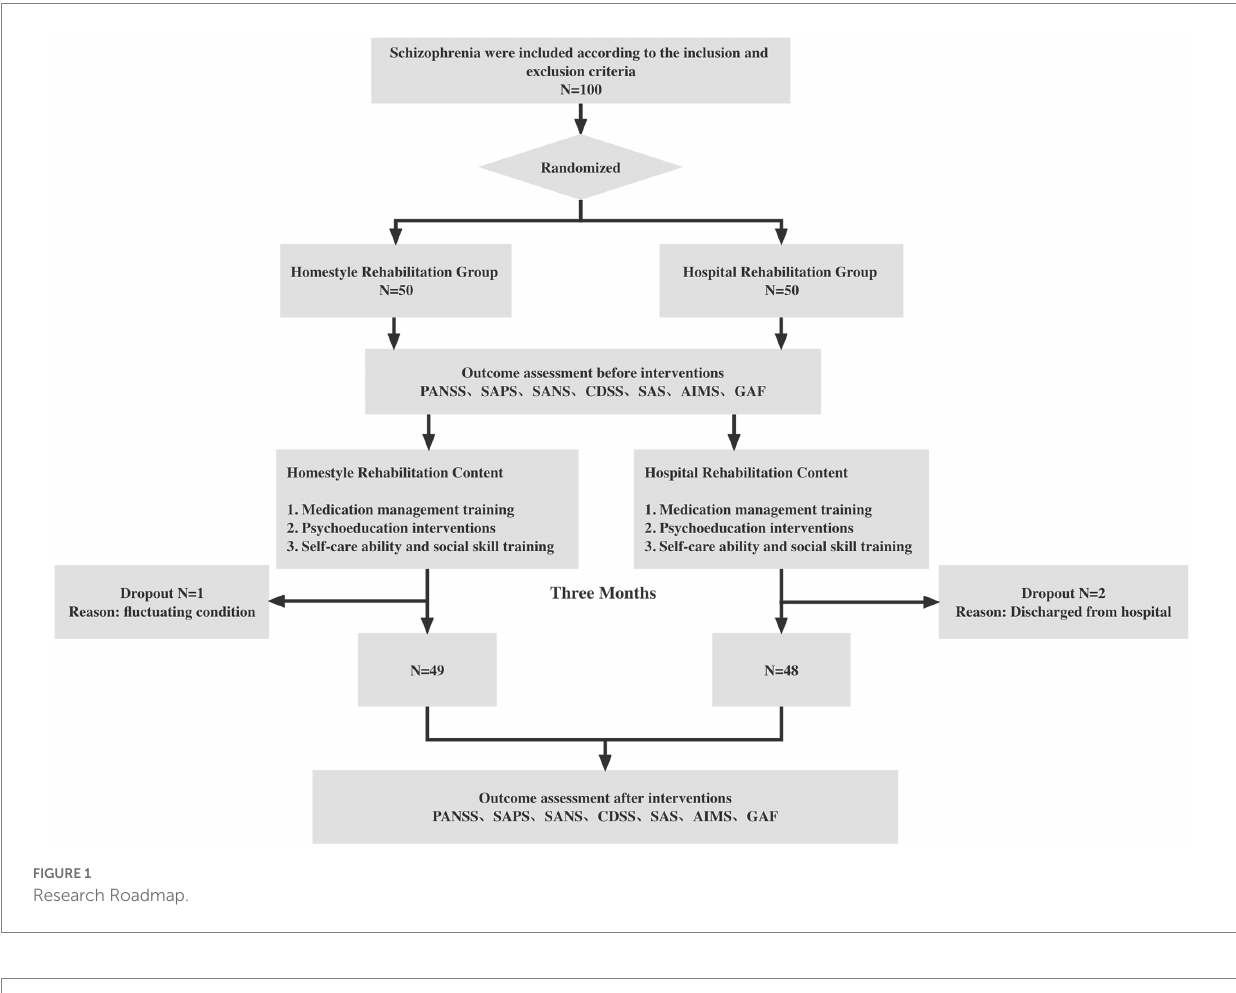
FIGURE 1 Research Roadmap.